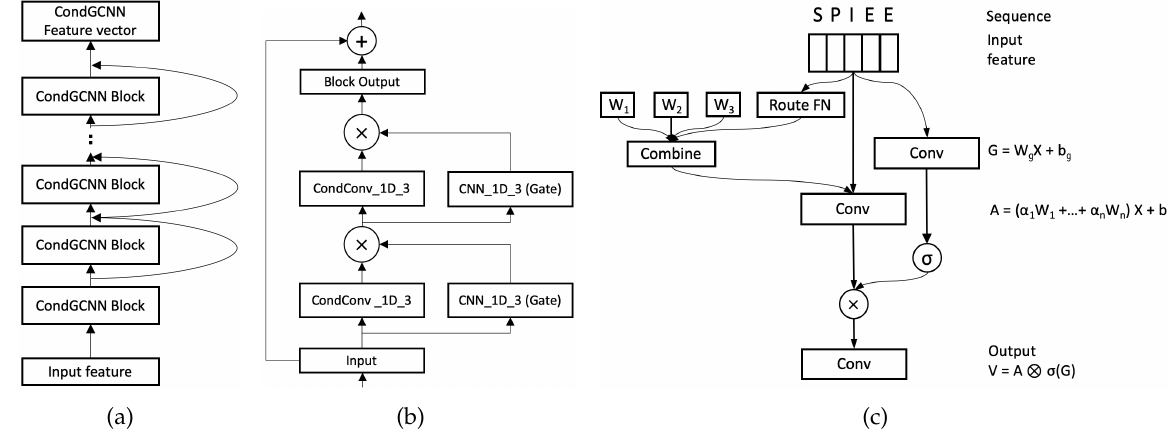
Figure 3. ( a ) CondGCNN encoder contains 32 blocks to get the feature vectors. ( b ) Each Figure 3. (a) CondGCNN encoder contains 32 blocks to get the feature vectors. (b) Each block contains 2 layers of Conditionally Parameterized Gated Convolutional network. The input vector of Input block is added to the output vector of the Block Output , the combination then input to the next block. (c) One layer of CondGCNN contains two parallel convolutional layers, one is the conditionally convolutional layer (A) and the other one is the gated layer (G). The output V is obtained by the element-wise production of A and σ (G).